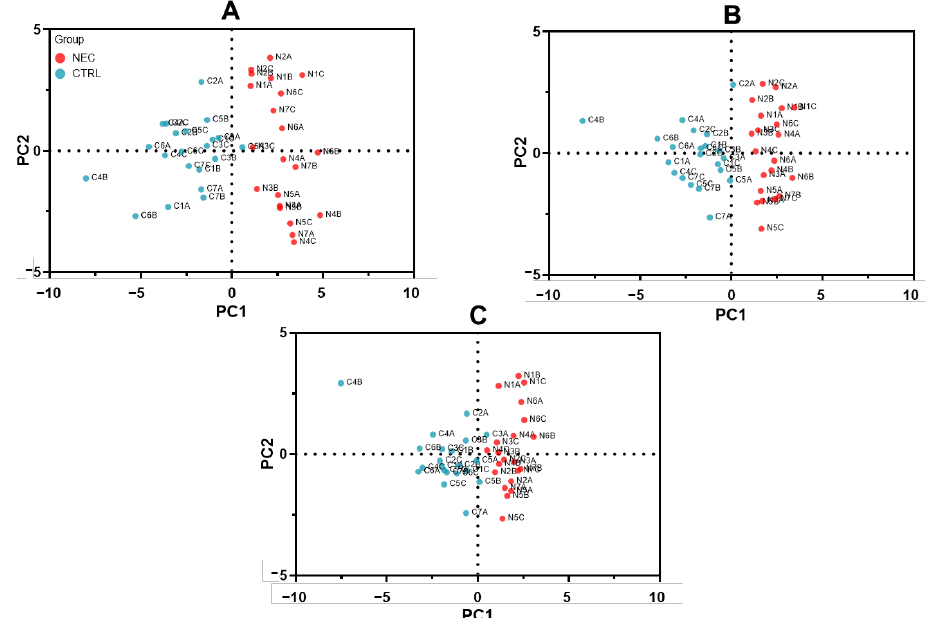
Figure 6. PCA of the 36, 20 and 14 series of markers. ( A – C ) PC score plots from the PCA of the ( A ) 36 (18 up, 18 down), ( B ) 20 (10 up, 10 down) and ( C ) 14 (7 up, 7 down) series of protein markers clustering showing the capacity of this series to form discrete clusters of the NEC (N1 to N7 group A, B, C: in red) and non-NEC control (C1 to C7 group A – C : in blue) samples with the two first principal components (PC1: x-axis; PC2: y-axis). Table 2. PC regression on the first PC score coordinates.